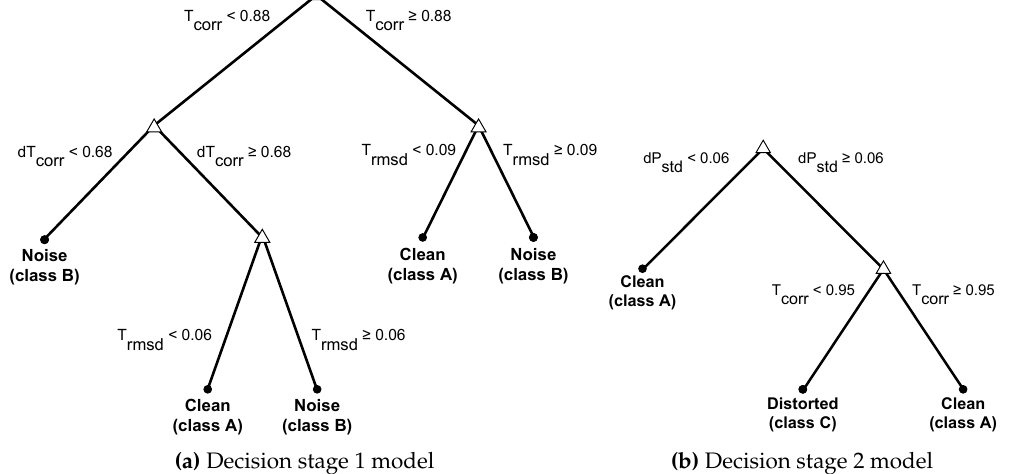
Figure 3. Decision trees used in the decision-making stages of the P-wave quality index (PQI) tool. These models used features obtained from the P-wave signal and P-wave template